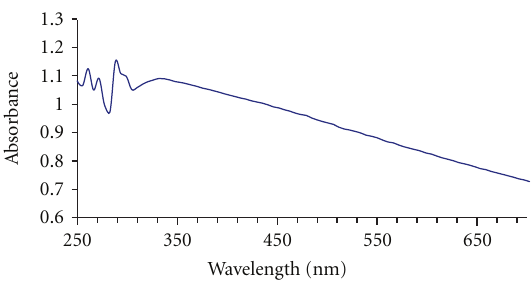
Figure 2: UV/Vis spectrum of fabricated nanoparticles in